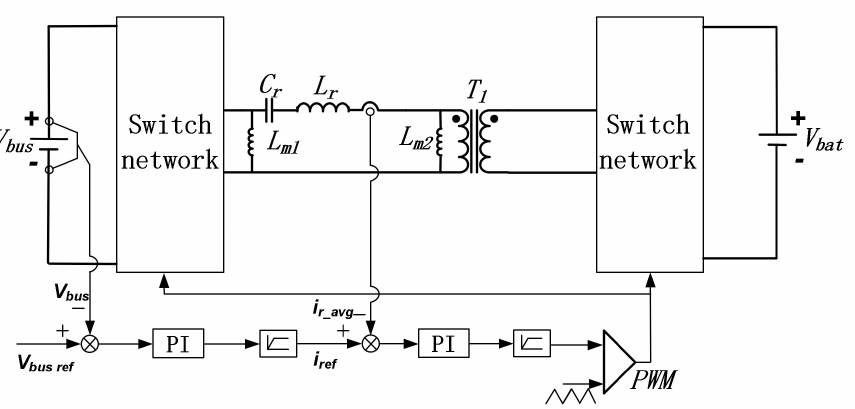
Figure 13. Control block diagram of the converter under discharging